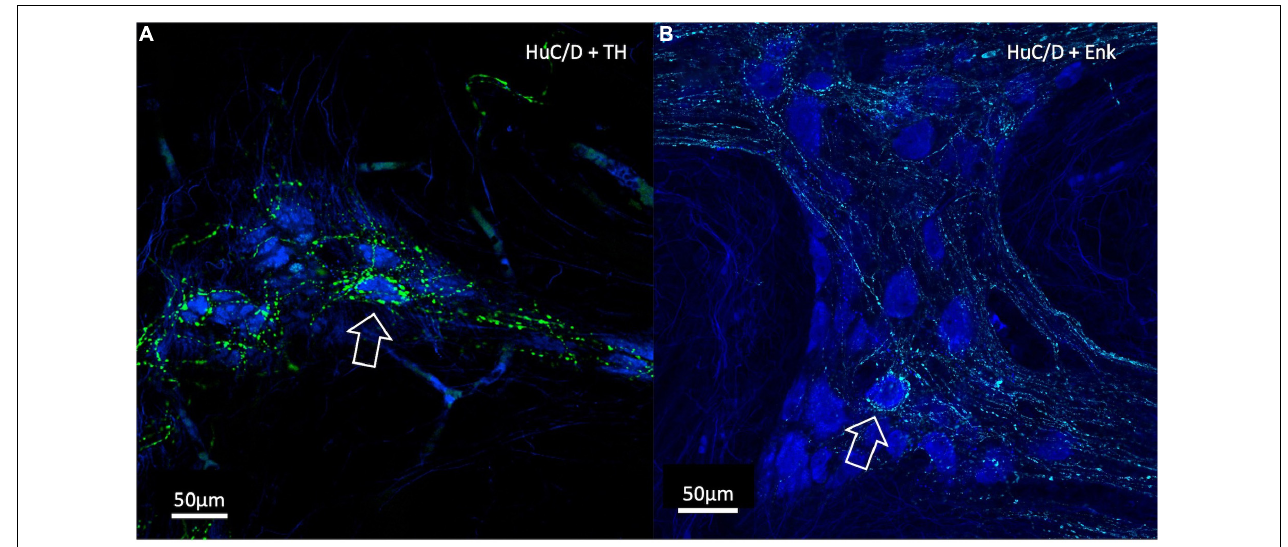
FIGURE 7 | Confocal Images of HuC/D cells with surrounding varicosity baskets. TH varicosities are in green, ENK varicosities are in cyan and HuC/D myenteric cell bodies are in blue. (A) A TH-immunoreactive basket of varicosities surrounding an individual HuC/D cell (open arrow). (B) An ENK varicosity basket surrounding an individual HuC/D cell (open arrow). In both cases, these myenteric cells were ChAT +. Baskets represent a high density of varicosities with close appositions encircling a myenteric cell body and are likely to indicate targetted neural connectivity. ChAT, Choline Acetyltransferase; NOS, Nitric Oxide Synthase; TH, Tyrosine Hydroxylase; ENK, Enkephalin.